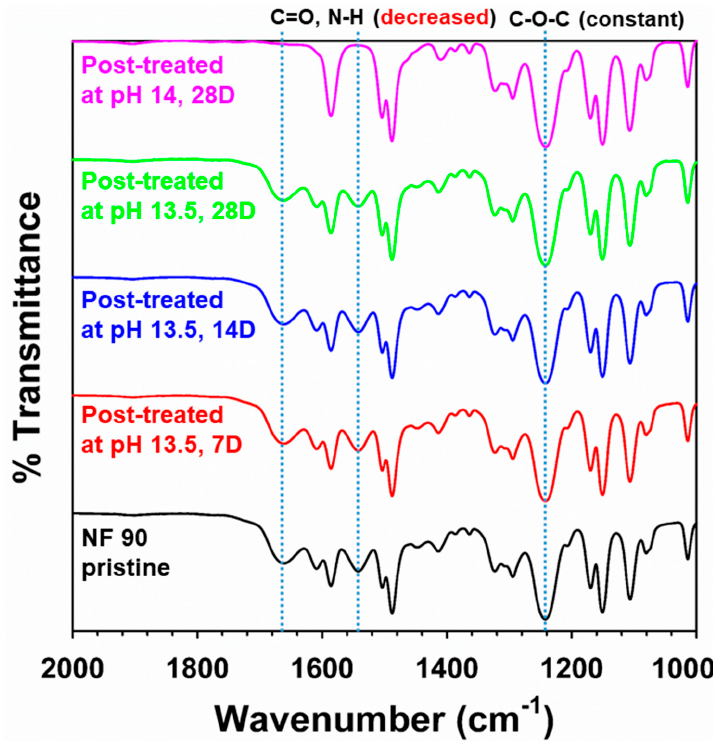
Figure 2. Effect of alkali hydrolysis on the peaks in FTIR spectra of NF 90 pristine and post-treated Figure membranes.